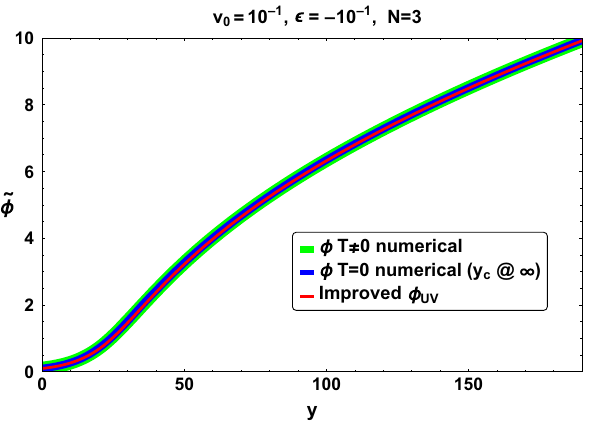
Fig. 11 Plots for (cid:7) φ and its derivative. Green is the lowest order UV solution, (cid:7) φ 0 e (cid:11) y , red is the analytic UV solution we are presenting, and blue are various full numerical results for the solution parameterized by √ (cid:14) (cid:7) φ (cid:6) ≡ 12 − (cid:7) φ (cid:6) ( y IR ) . The agreement in the deep UV is good for all IR